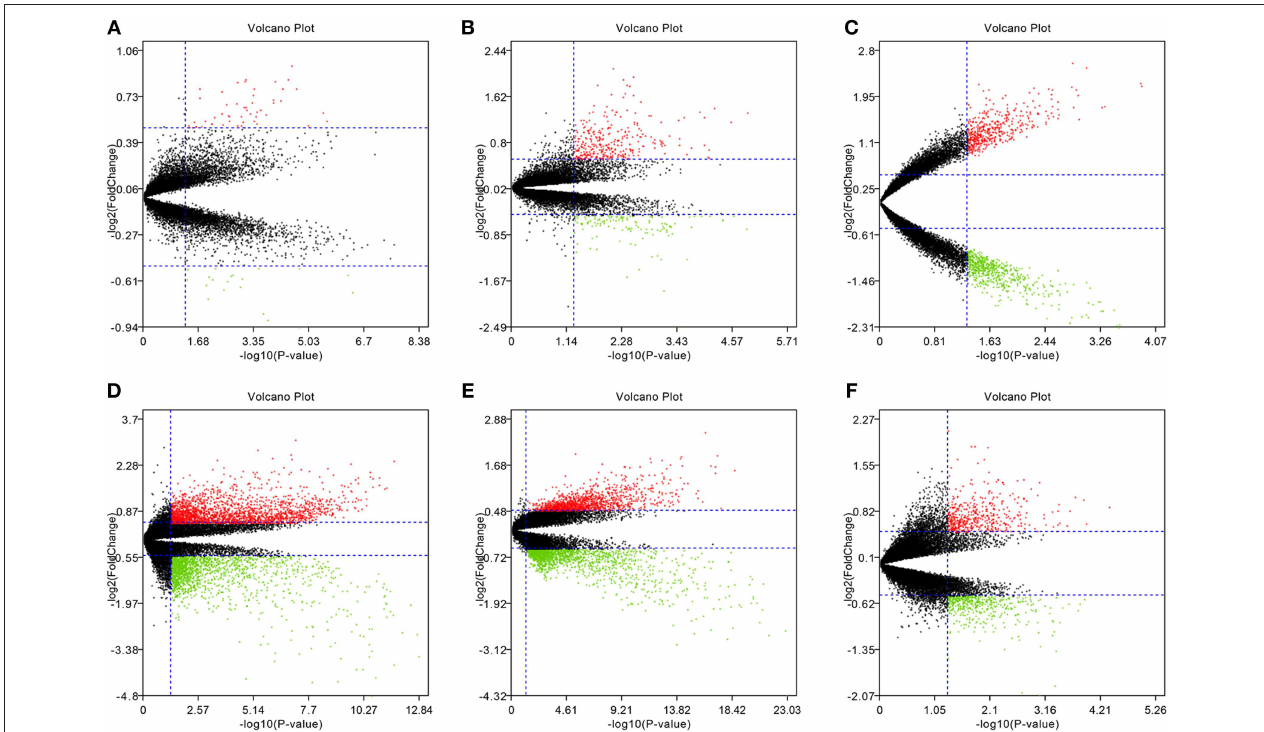
FIGURE 1 | Volcano plots of the six microarrays. Red points represented up-regulated genes, while green points represented down-regulated genes. Black points represented genes with no significant difference. (A) GSE48452, (B) GSE63067, (C) GSE66676, (D) GSE72756, (E) GSE89632, (F) GSE107231.